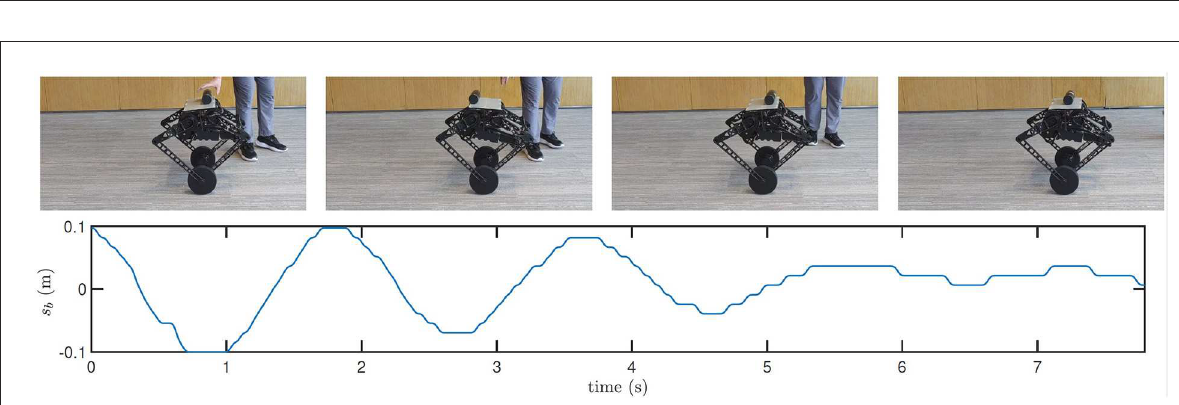
FIGURE14 Still images and real-time data obtained during bottle balancing using the AOOR. Many more maneuvers in action and experimental data are shown in the accompanying